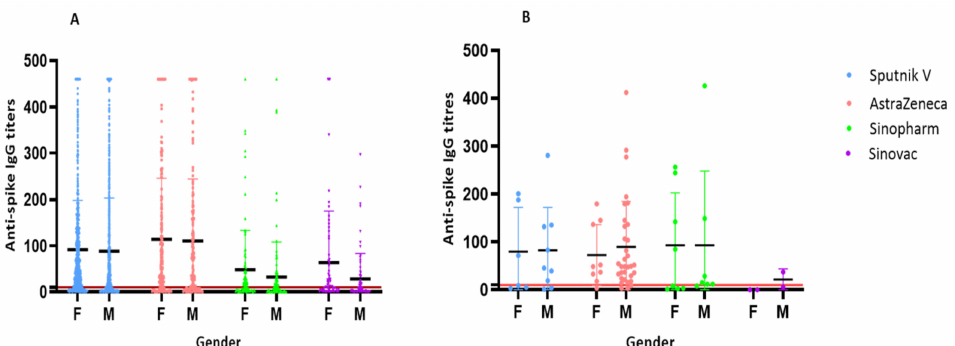
Figure 2. ( A ) Anti-spike IgG levels developed after each vaccine type by sex ≤ 12 weeks post- 1st vaccination dose. The IgG levels include both reactive (R: ≥ 10 AU/mL) and non-reactive (NR; <10 AU/mL) values. F denotes female and M denotes male. ( B ) Anti-spike IgG levels post 2nd vaccination dose. The chart shows similar median IgG titers in both male and females except in the group who received Sinopharm and Sinovac vaccines where females had significantly higher antibody